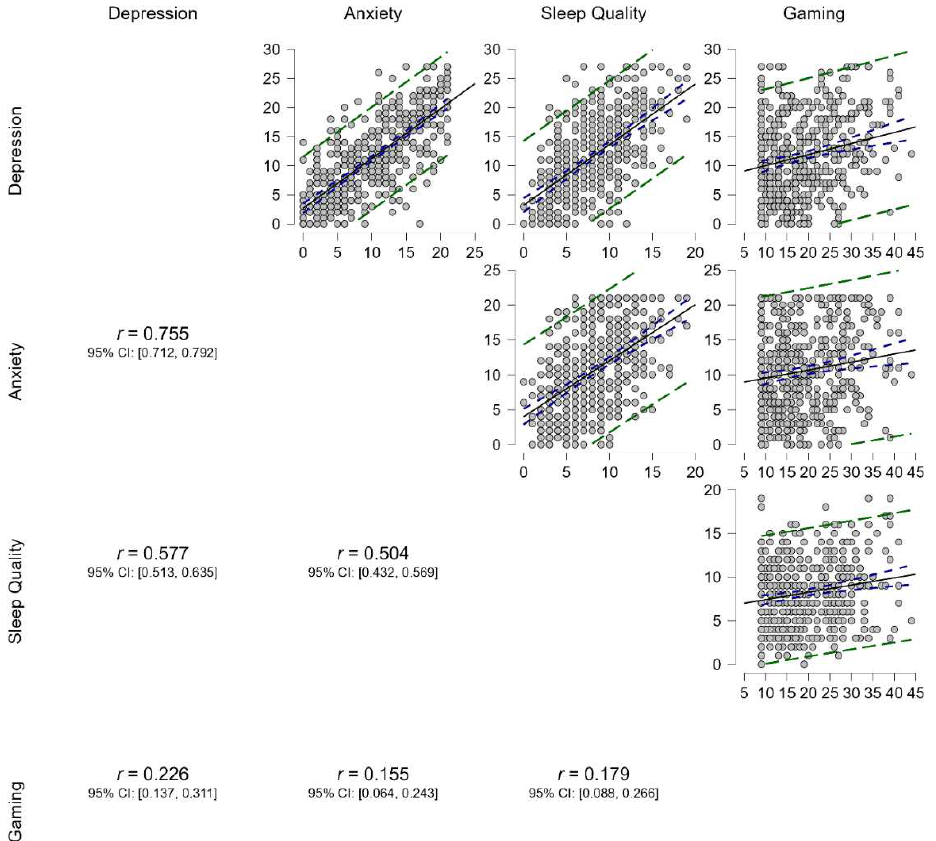
Figure 1. Pearson’s correlation between depression, anxiety, sleep quality, and gaming in a sample of undergraduates ( n = 457). Note: All correlations are significant at p < 0.001. The solid gray line represents the regression slope; the purple dashed line shows a 95% confidence interval; and the green dashed line means 95% prediction intervals.